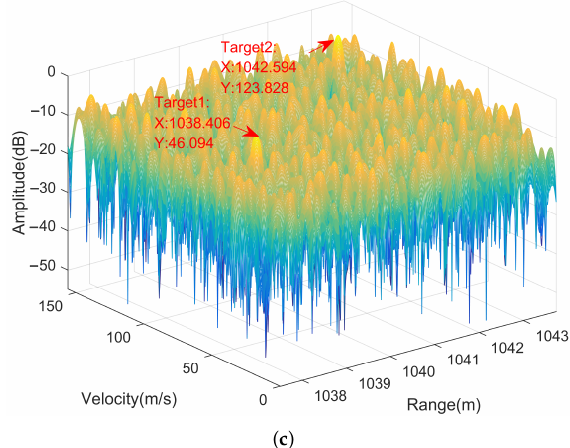
Figure 7. The results of signal processing for two targets: ( a ) Pulse compression and range and velocity estimations using ( b ) MUSIC algorithm and ( c ) correlation operation (Target1 [1038.4 m, 46 m/s], Target2 [1042.6 m, 124